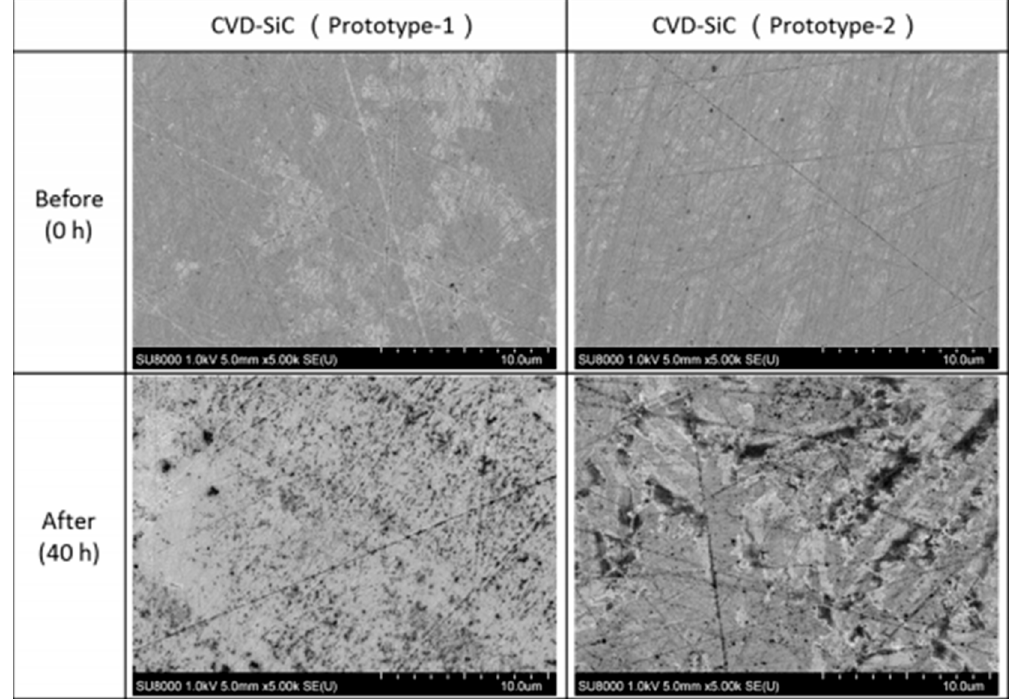
Figure 45. SEM images of CVD-SiC before and after corrosion testing. Reprinted with permission from Reference [159]. Copyright 2019 MDPI AG/Creative Commons Attribution License 4.0).